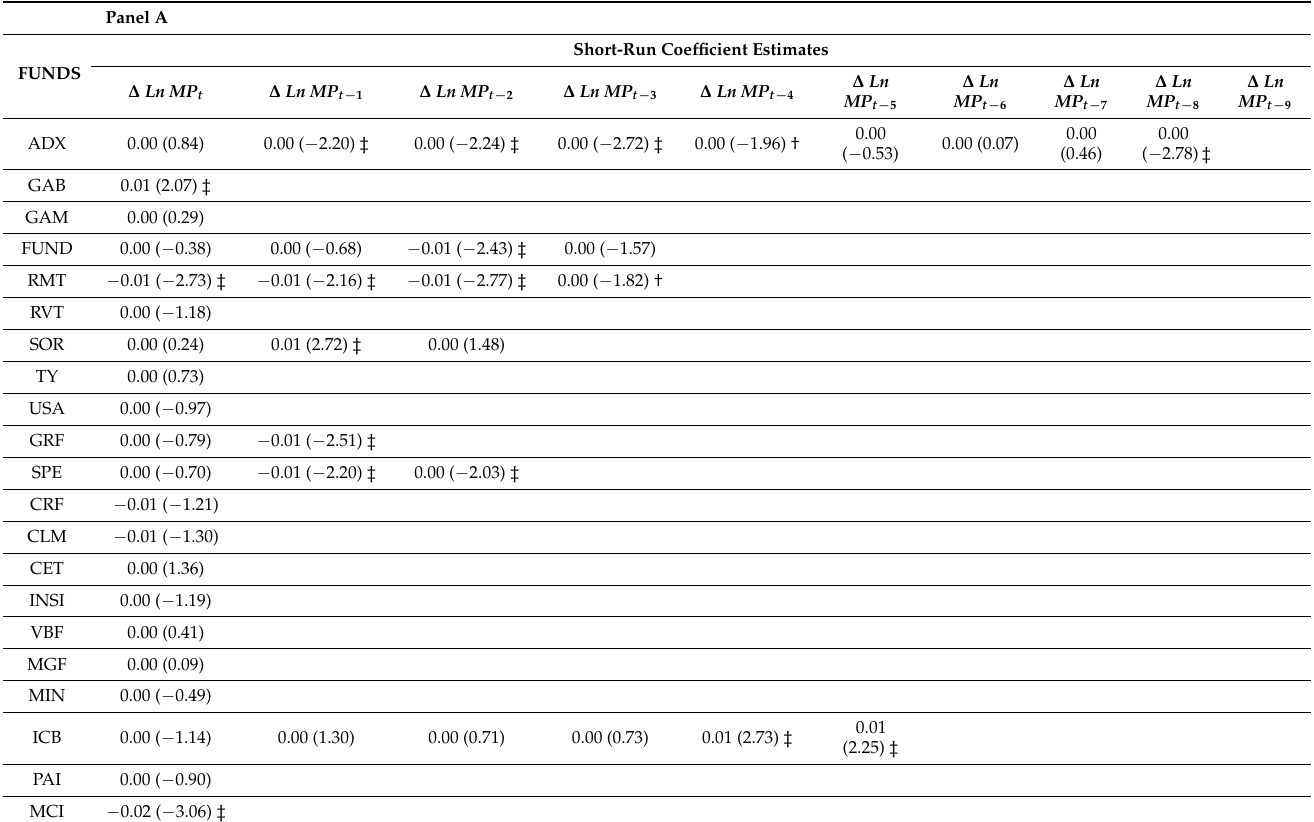
Table 2. Short-Run Coefficient Estimates—Linear ARDL—Model P = f (NAV,